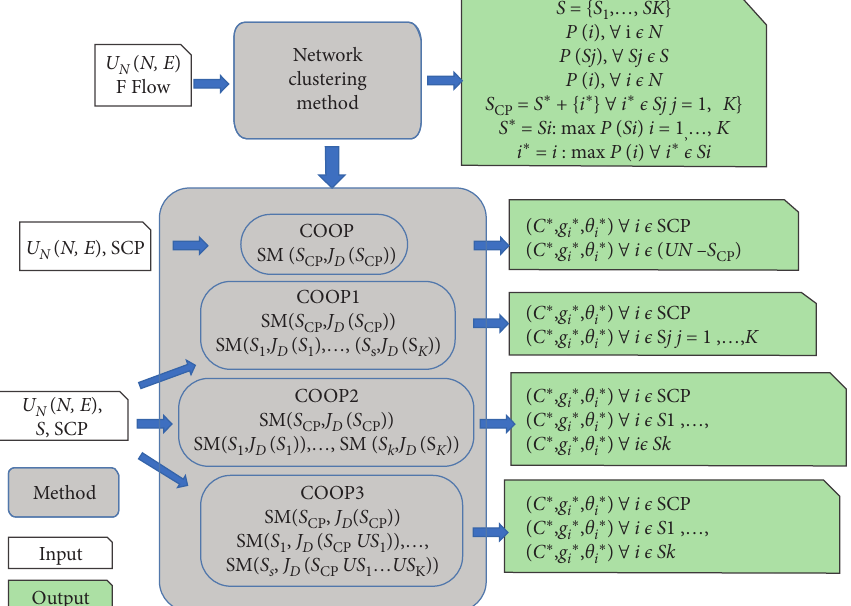
Figure 4: Procedure providing the clustering and the signal setting parameters of the urban